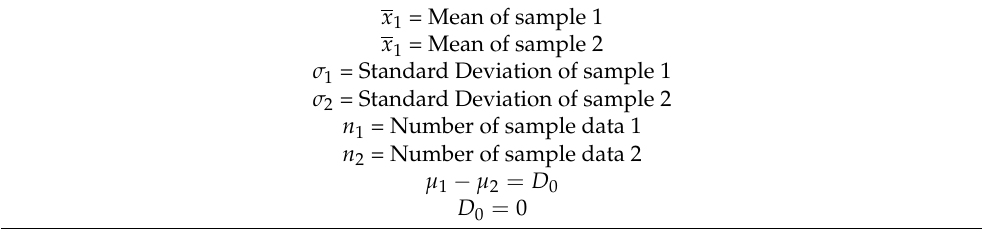
Table 11. Hypothesis Test Parameters.